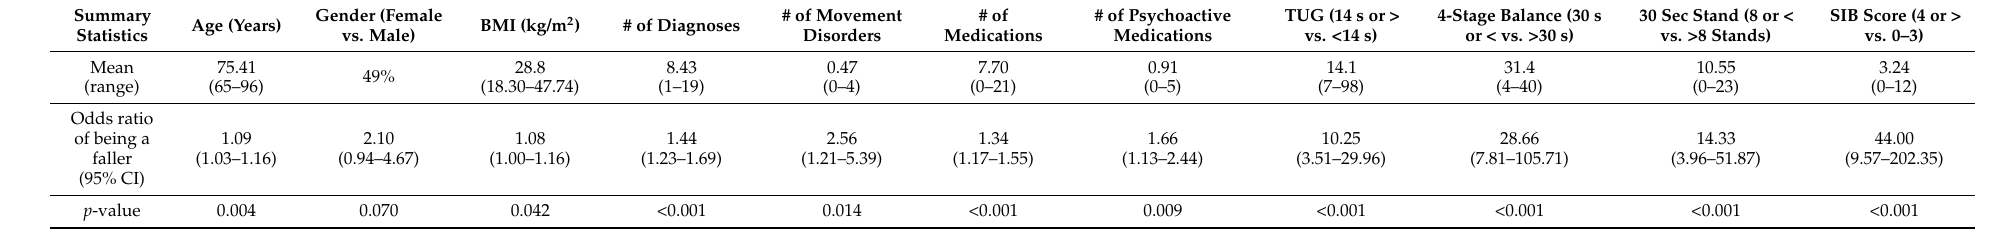
Table 2. Summary statistics of participants’ attributes, medications, health and fall history, and fall-risk assessment measurement